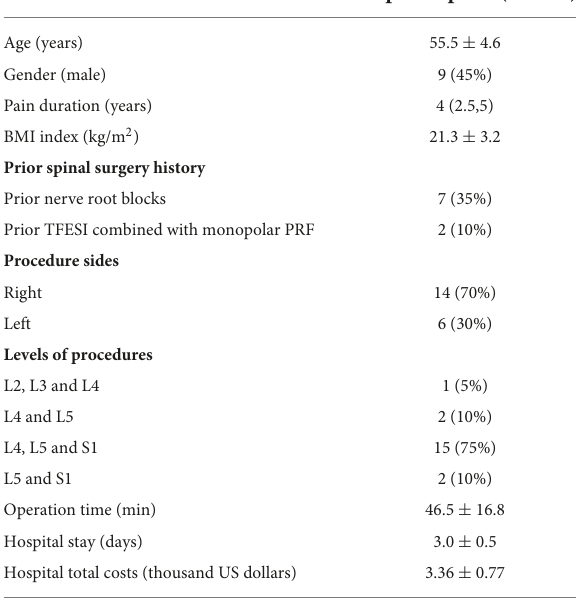
TABLE 1 General demographics of participants.